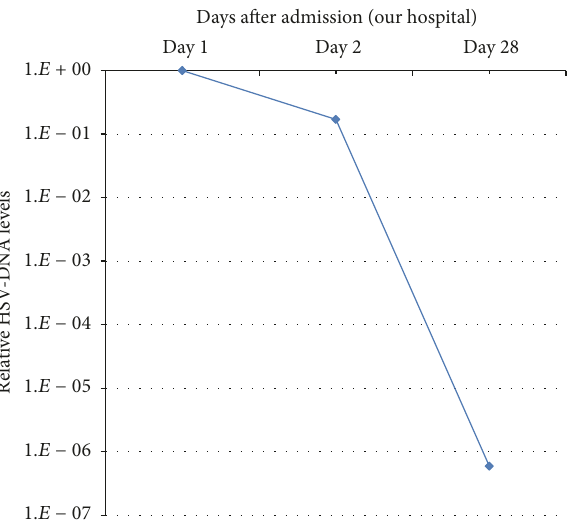
Figure 5: Relative HSV-DNA levels on days 1, 2, and 28. HSV-DNA levels decreased to lower than 10 −6 from day 1 to day